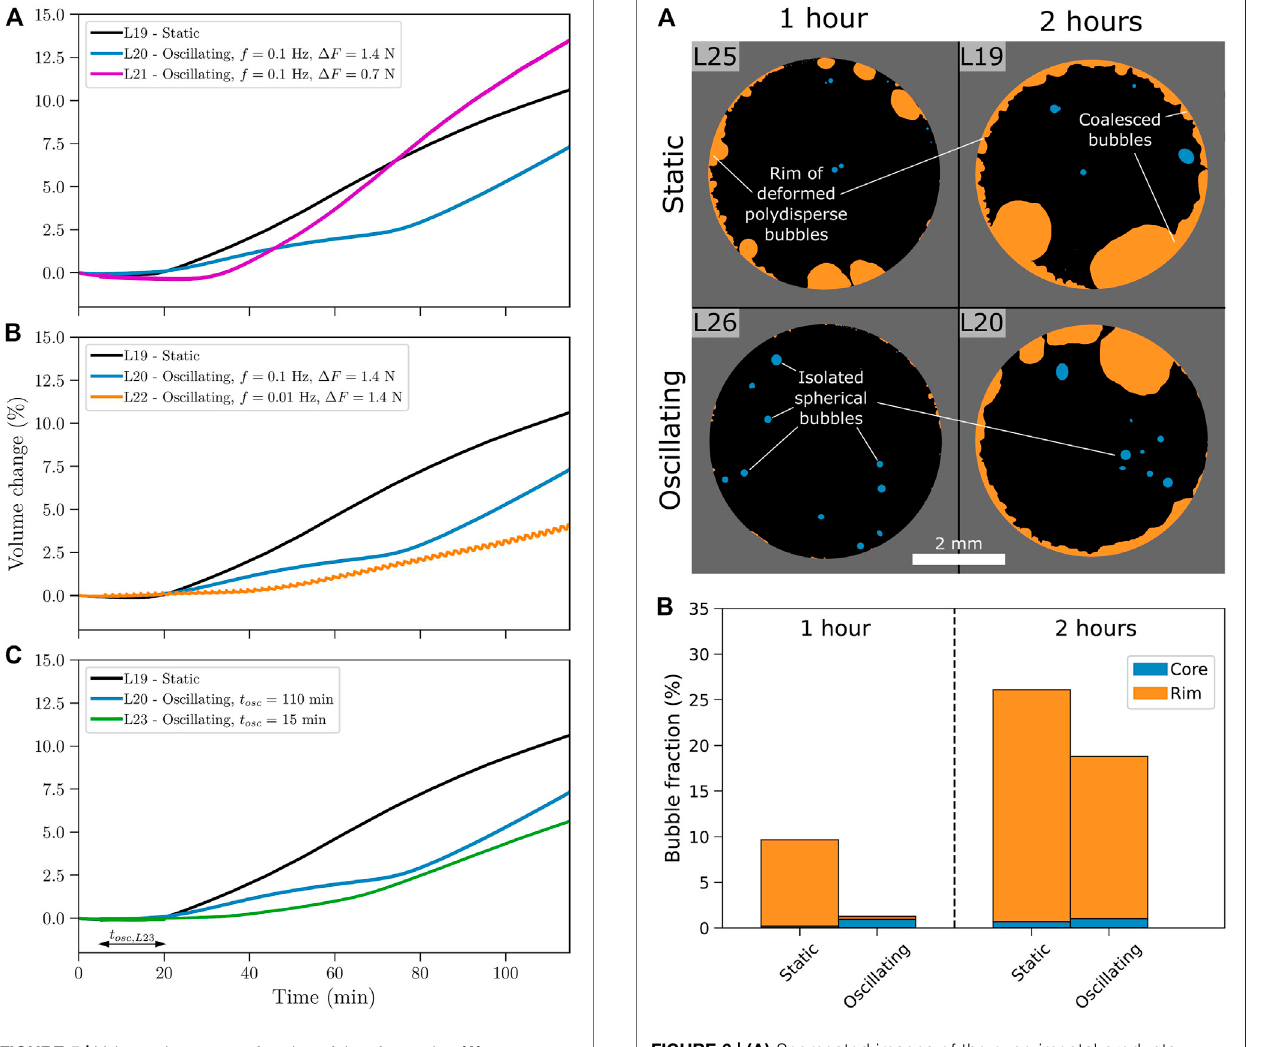
FIGURE 5 | Volume change as a function of time for varying (A) oscillationamplitude Δ F , (B) oscillationfrequency f ,and (c) oscillationduration t osc . Time is set to zero 5 min after the isotherm is reached. In (C) , the oscillationperiodfortheshortoscillationdurationexperiment(L23)starts 10 minafter theisotherm isreached(i.e., t =5 min on thegraph) and isshown as a double headed black arrow labelled t osc , L 23 ; for all other oscillating experiments, the oscillation starts at t = 5 min and continues until the end of the experiment at t = 115 min, i.e., for a duration of t osc = 110 min. For each plot, data from a baseline static (L19, black line) and oscillating (L20, blue line) experiment are shown. Theseare the same two 2-h experiments presented in Figure 4 . All experiments are performed at T = 965 ° C and F 0 = 1.5 N. All experimental parameters are reported in Table 3 .